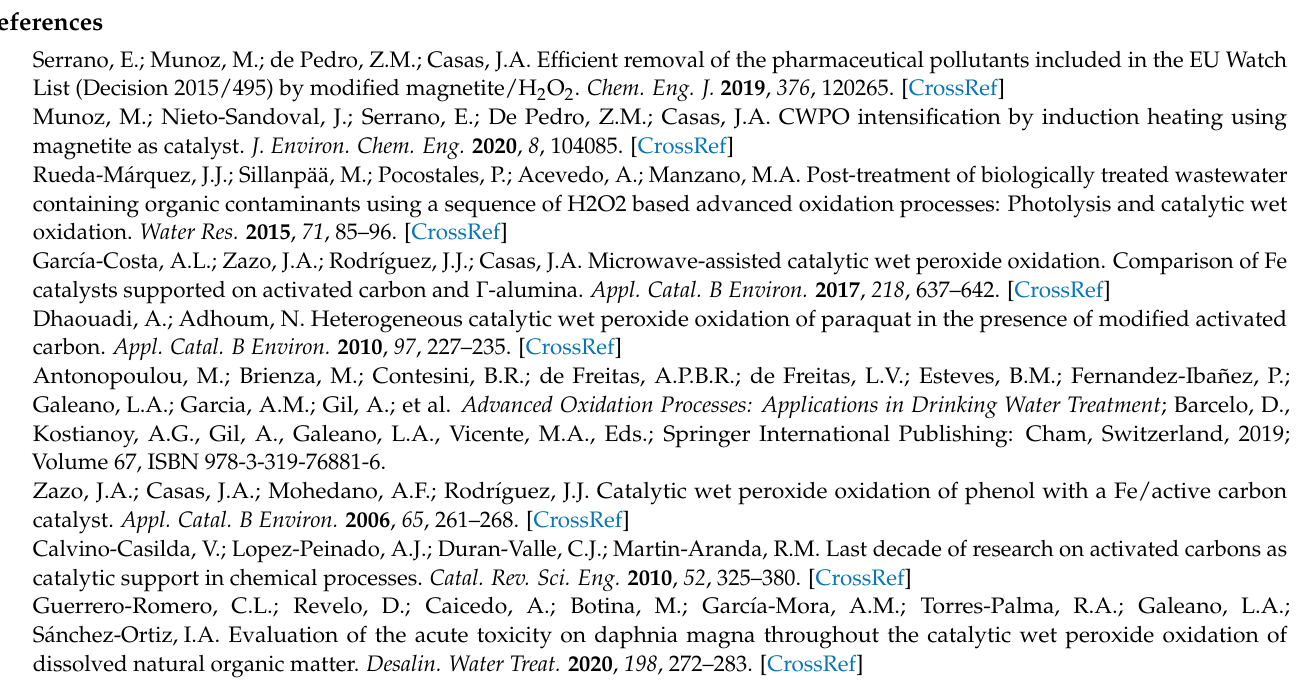
catalysts. Figure S2: N2 isotherms of Fe/AC-f catalysts: (a) Fe/CM-f catalysts and (b) Fe/CN-f catalysts. Table S1: Catalysts nomenclature and